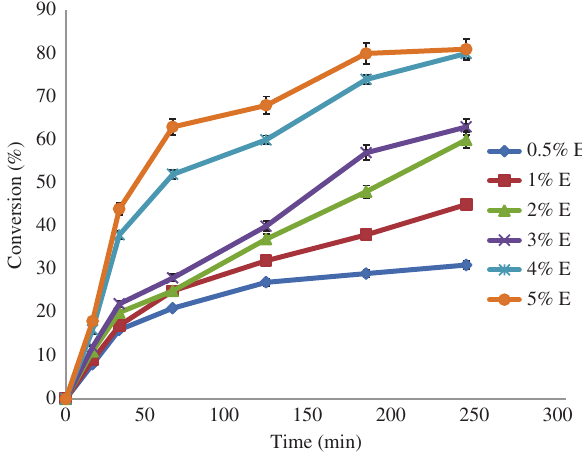
Figure 4: Effect of enzyme loading on conversion at hexanol:triacetin ratio 1:1, hexane 3 ml, temperature 50 ° C, agitation speed 100 rpm, power 60 W, duty cycle 80% and frequency 25